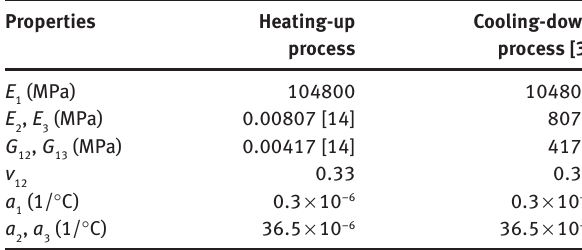
Table 1: Material properties of